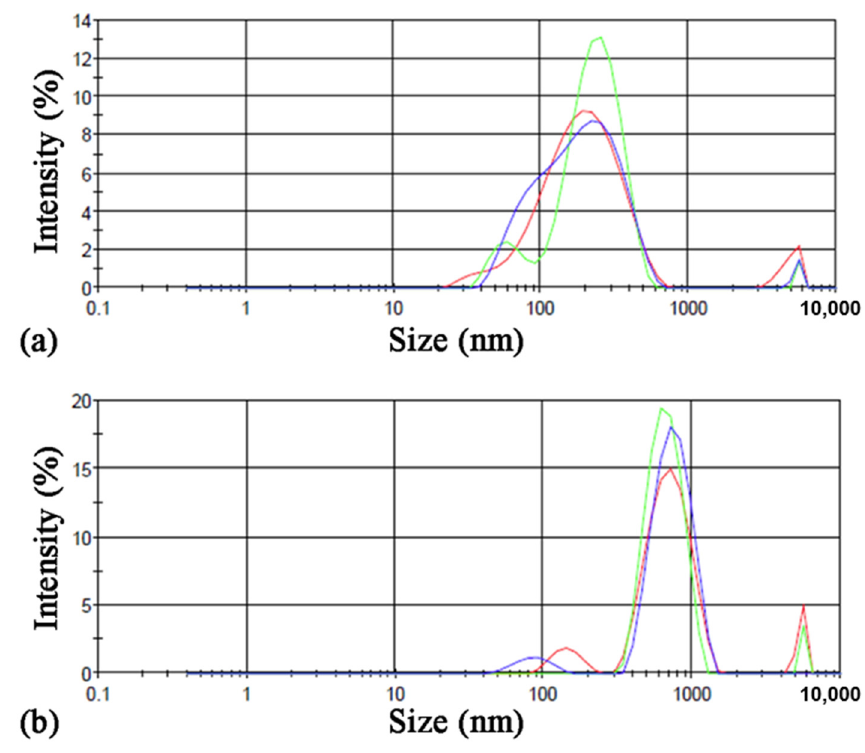
Figure 5. FT-IR analysis of ONC-GMA/EGDMA.